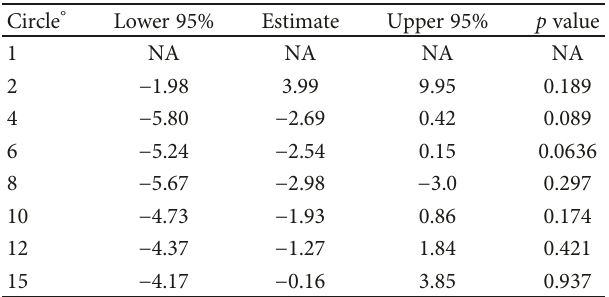
Table 3: Comparing microperimetry values of ARAM+ with those of ARAM − from the same distance to fovea (1 ° to 15 ° circle) within the